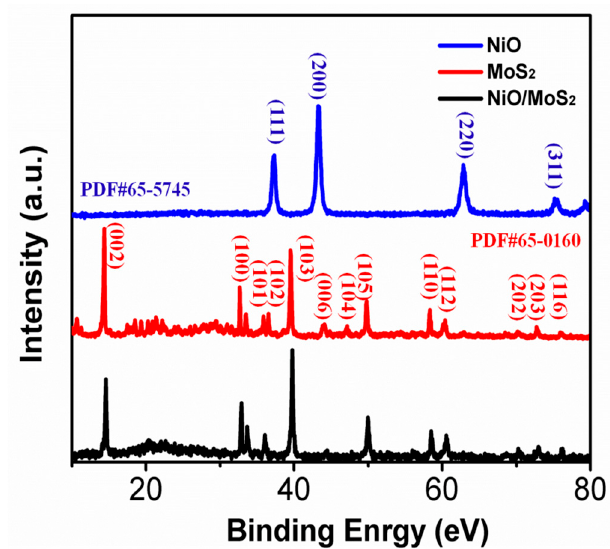
Figure 1. XRD patterns for MoS 2 :NiO-3:1, NiO and MoS 2.